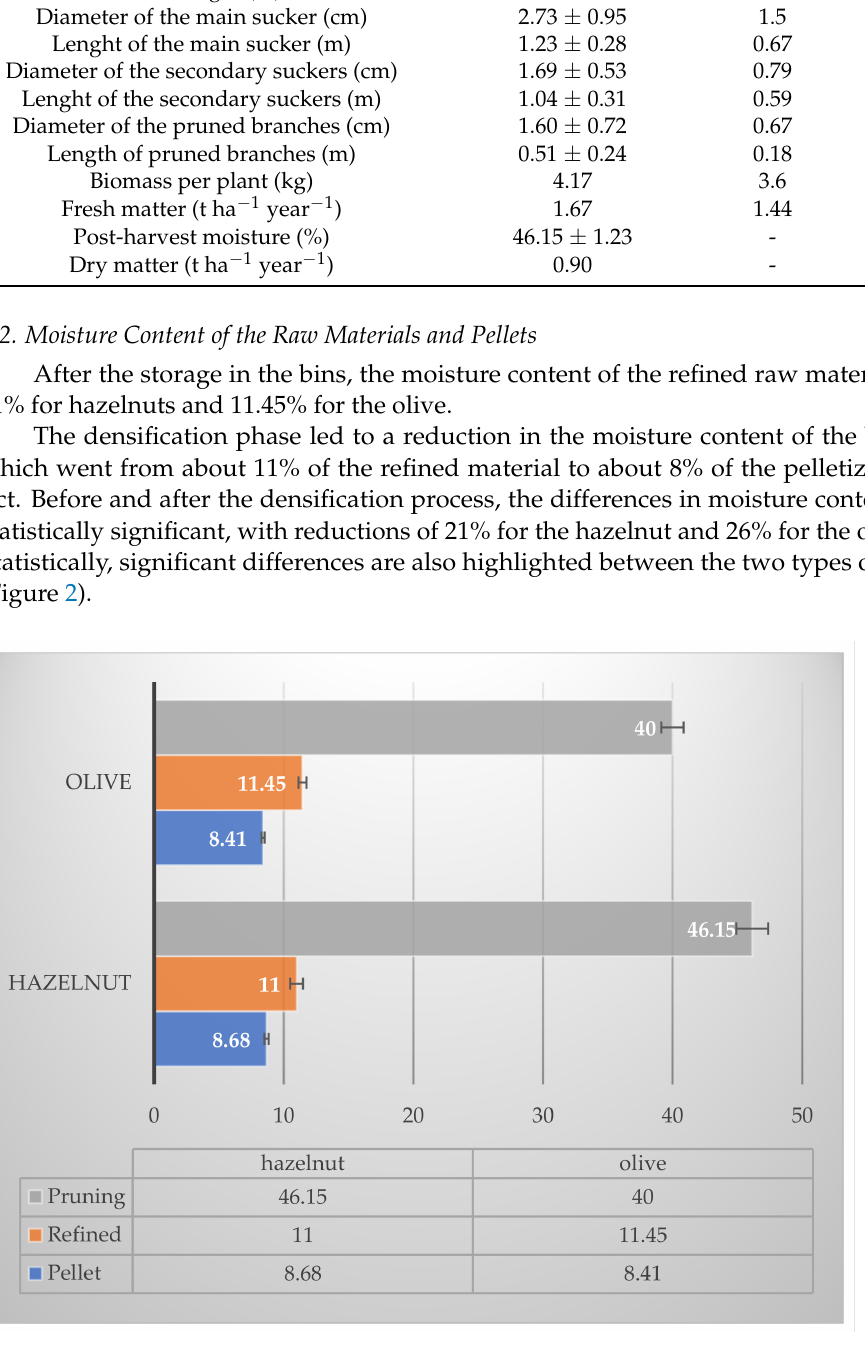
Figure 2. Moisture content (%) of the raw material (chip, refined) and pellet ± St.